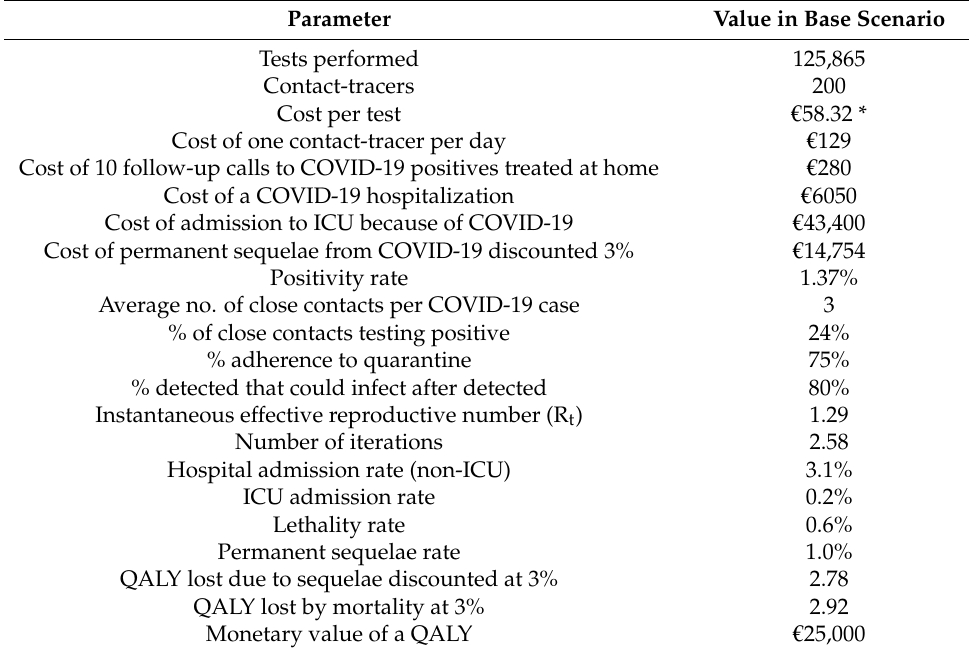
Table 2. Parameters used to calculate cases avoided, base scenario settings (all screenings).